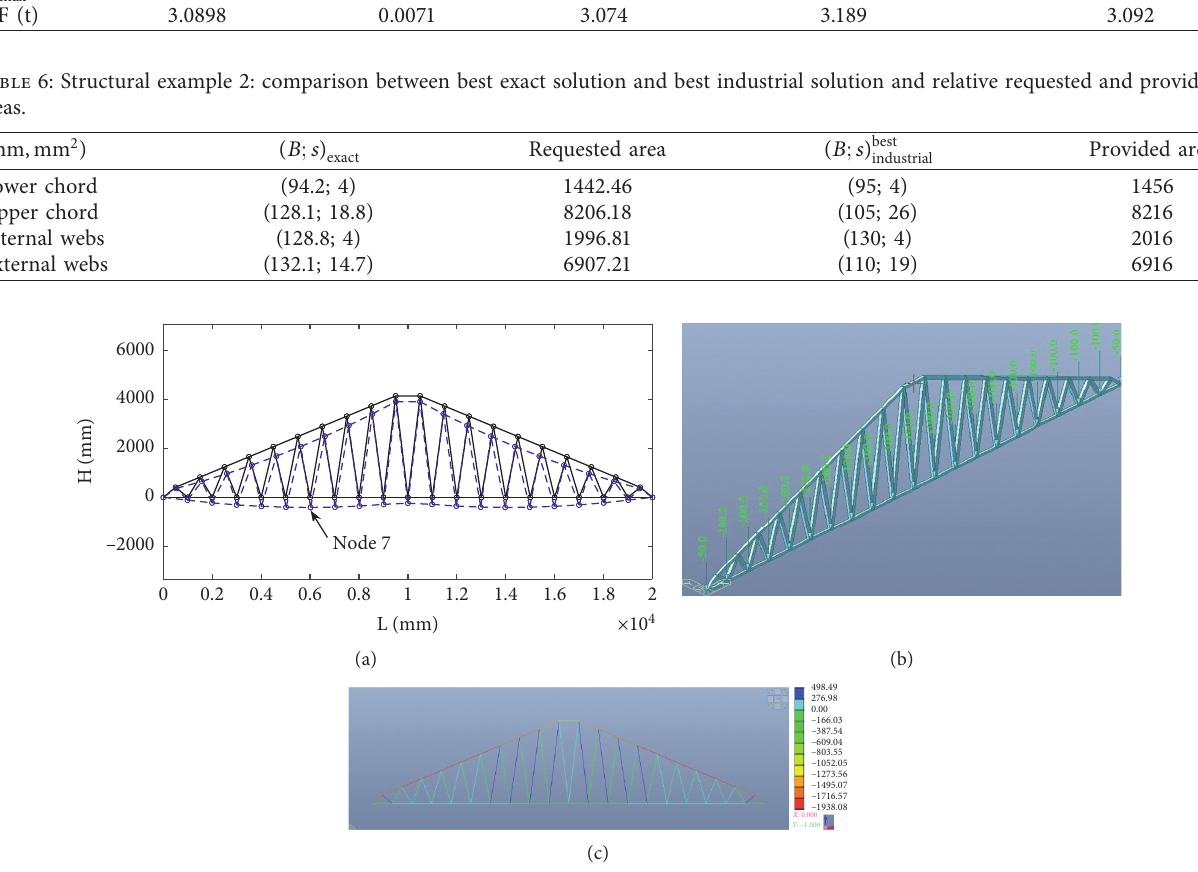
Figure 9: Structural example 2. (a) Optimal Warren truss, solid Line: undeformed shape; dashed line: deformed shape. (b) View of the model of the Warren truss beam on Midas Gen ® . (c) Planar view of the Warren truss beam on Midas Gen ® with the axial force